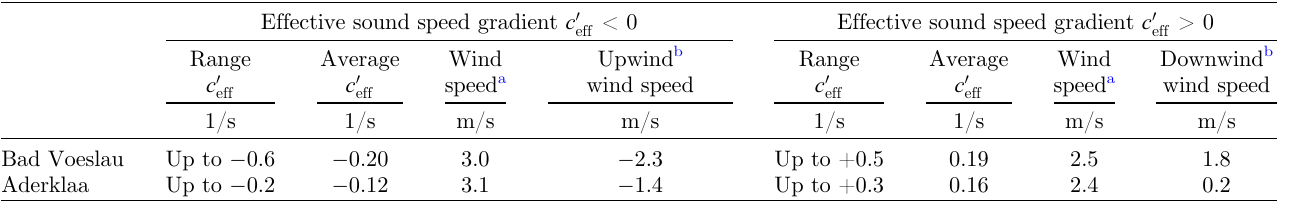
Table 1. Comparison of the (average) meteorological data of Bad Voeslau and